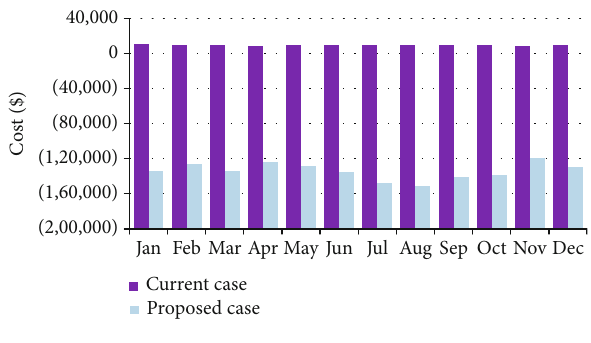
Figure 9: Monthly utility bills. Table 5: Annual utility bills and savings by